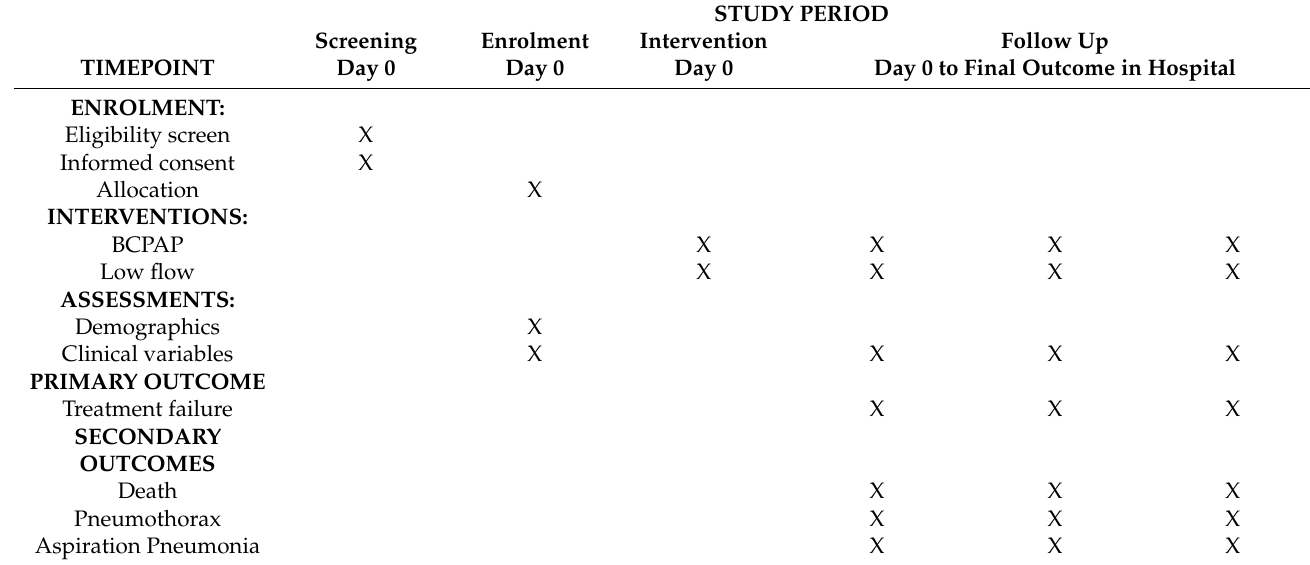
Table 1. Standard Protocol Items: Recommendation for Interventional Trials (SPIRIT) figure showing the schedule of enrollment, interventions, and assessments. STUDY PERIOD Screening Enrolment Intervention Follow